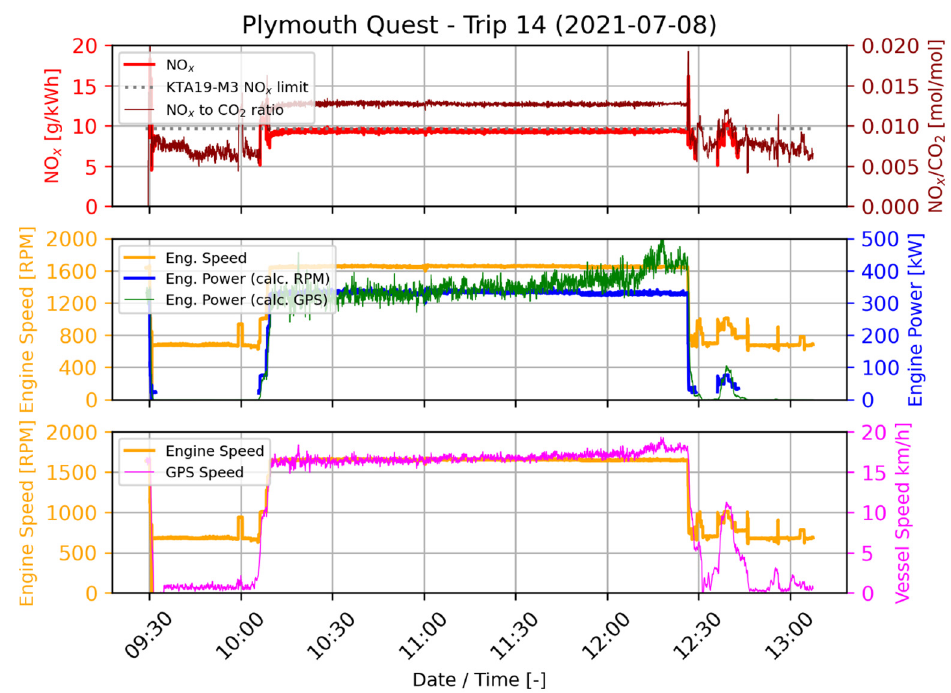
Figure 7. Emissions data and ship parameters from RV Plymouth Quest (Trip